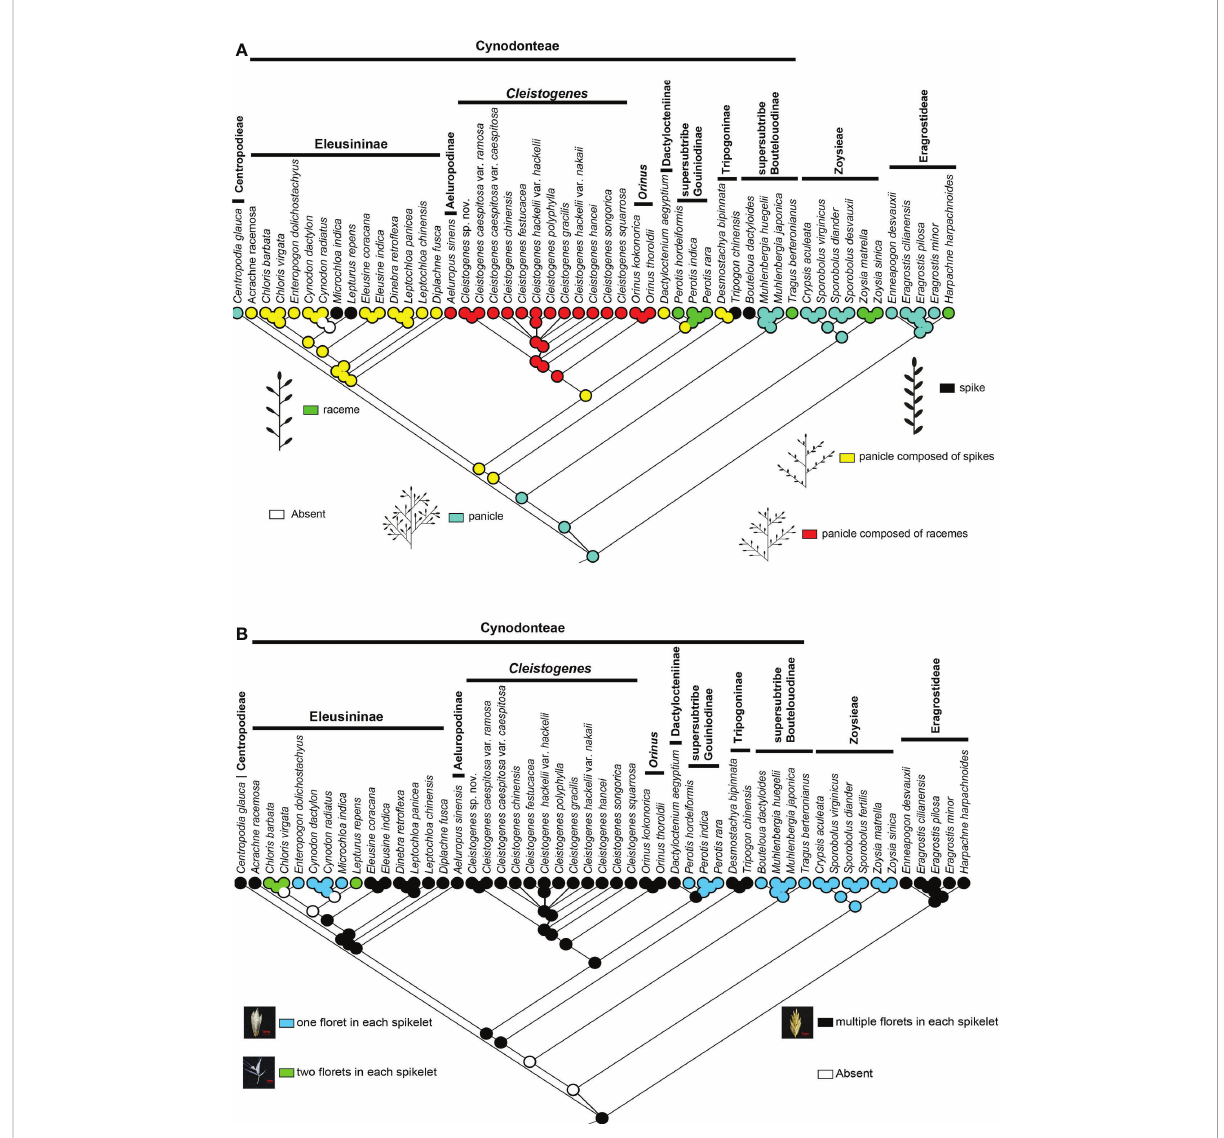
FIGURE 4 Ancestral state reconstructions of in Chloridoideae: (A) in fl orescence type; (B) spikelet type. The differently coloured spots at the nodes indicate the different character